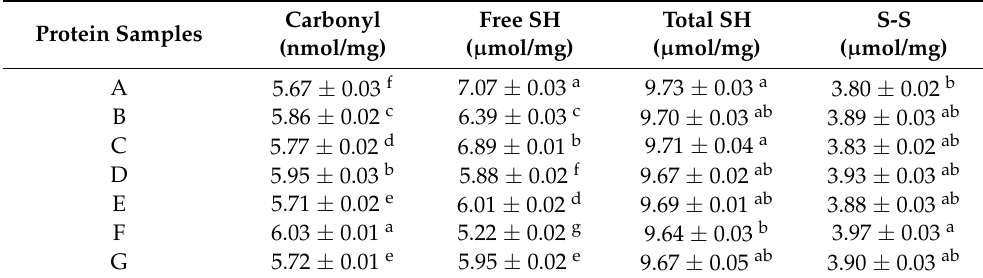
Table 2. The carbonyl, free sulfhydryl (SH), total SH groups, and S-S bond content of oxidized soy protein isolate (SPI) before and after cavitation jet treatment.